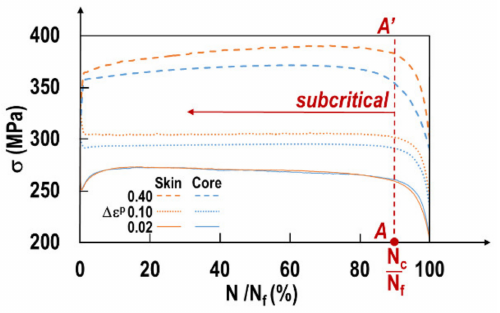
Figure 12. Stress as function of the normalized number of cycles for all considered